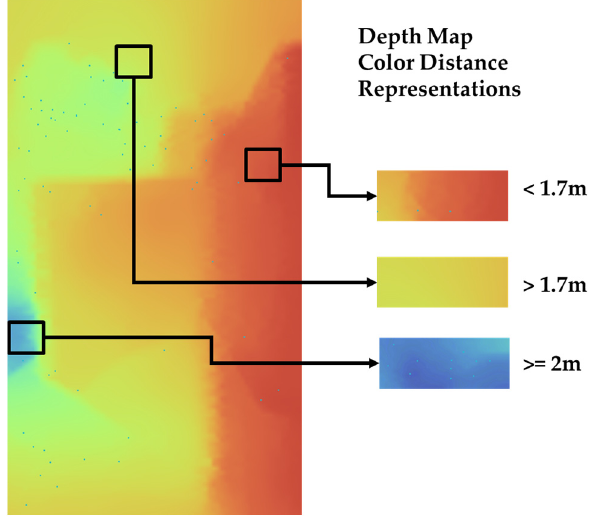
Figure 8. Depth map color distance representations with red distance as <1.7 m, yellow or green > 1.7 m, and blue >= 2 m .